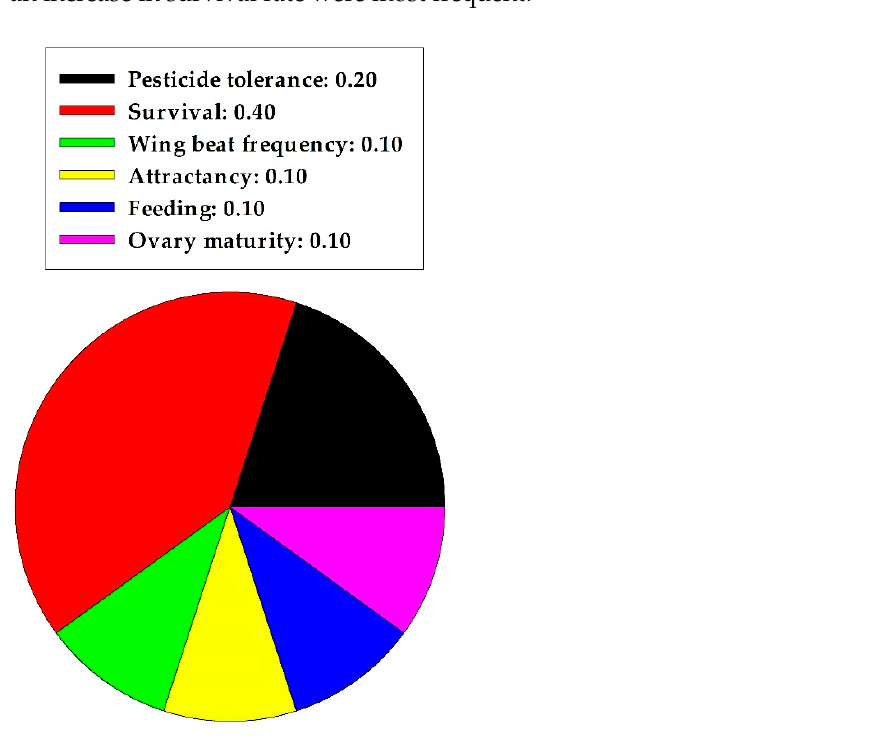
Figure 4. Proportion of specific nonharmful effects of quercetin on pollinators in one insect order.